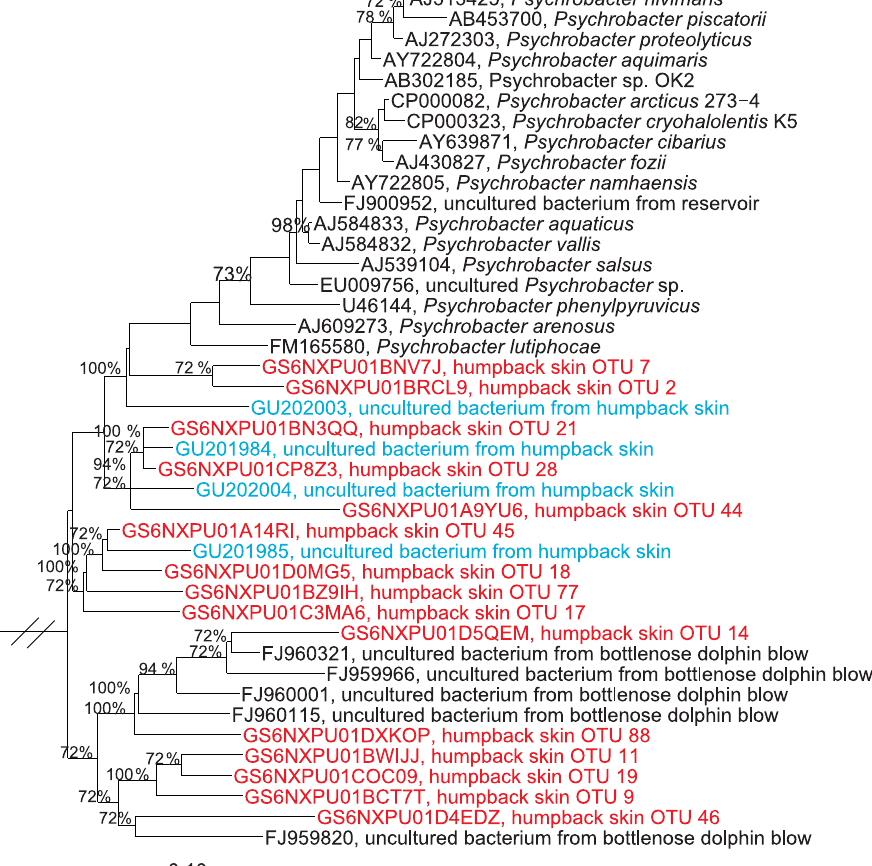
Figure 7. Phylogenetic relationship of Psychrobacter-affiliated sequences. Represented SSU rRNA gene sequences include Psychrobacter - affiliated sequences recovered from whale-skin, cultivated Psychrobacter isolates, and relatives within the Gammaproteobacteria . Red colored sequences are short-reads from this study, and blue full-length sequences are from a previous study [8]. The scale bar corresponds to 0.10 substitutions per nucleotide position, and only bootstrap values . 70 are listed. Sequences from Hymenobacter soli (AB251884), Salegentibacter flavus (AY682200) and Ureaplasma urealyticum were used to form the outgroup.